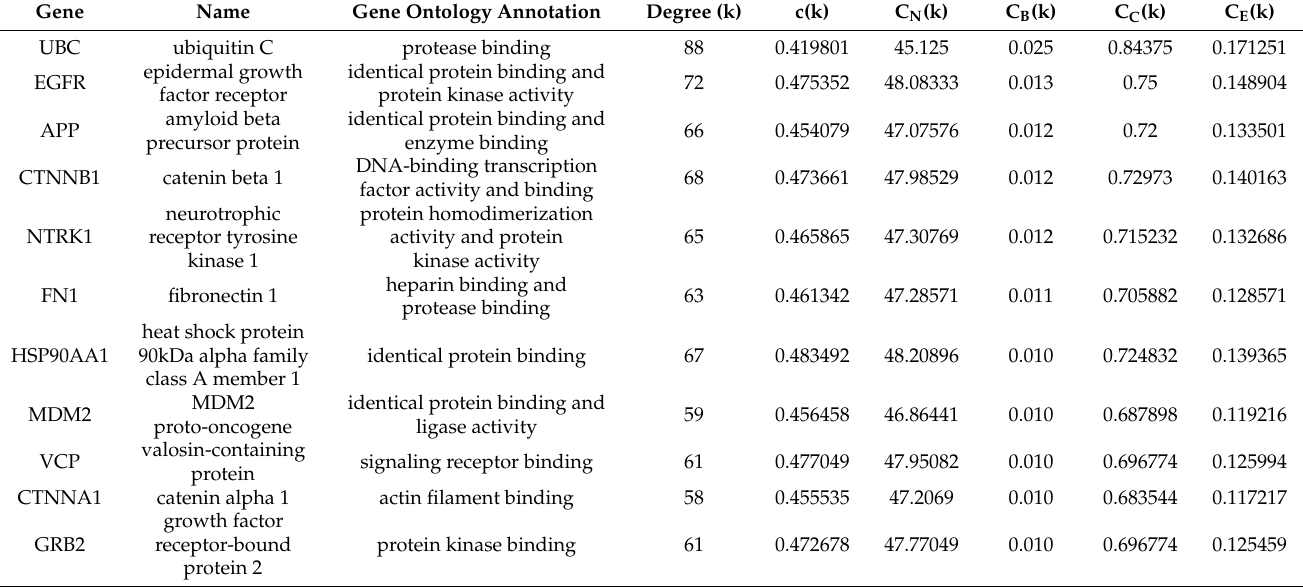
Table 1. High-degree hubs with topological properties from resultant “druggable genome–motif- localized hubs”